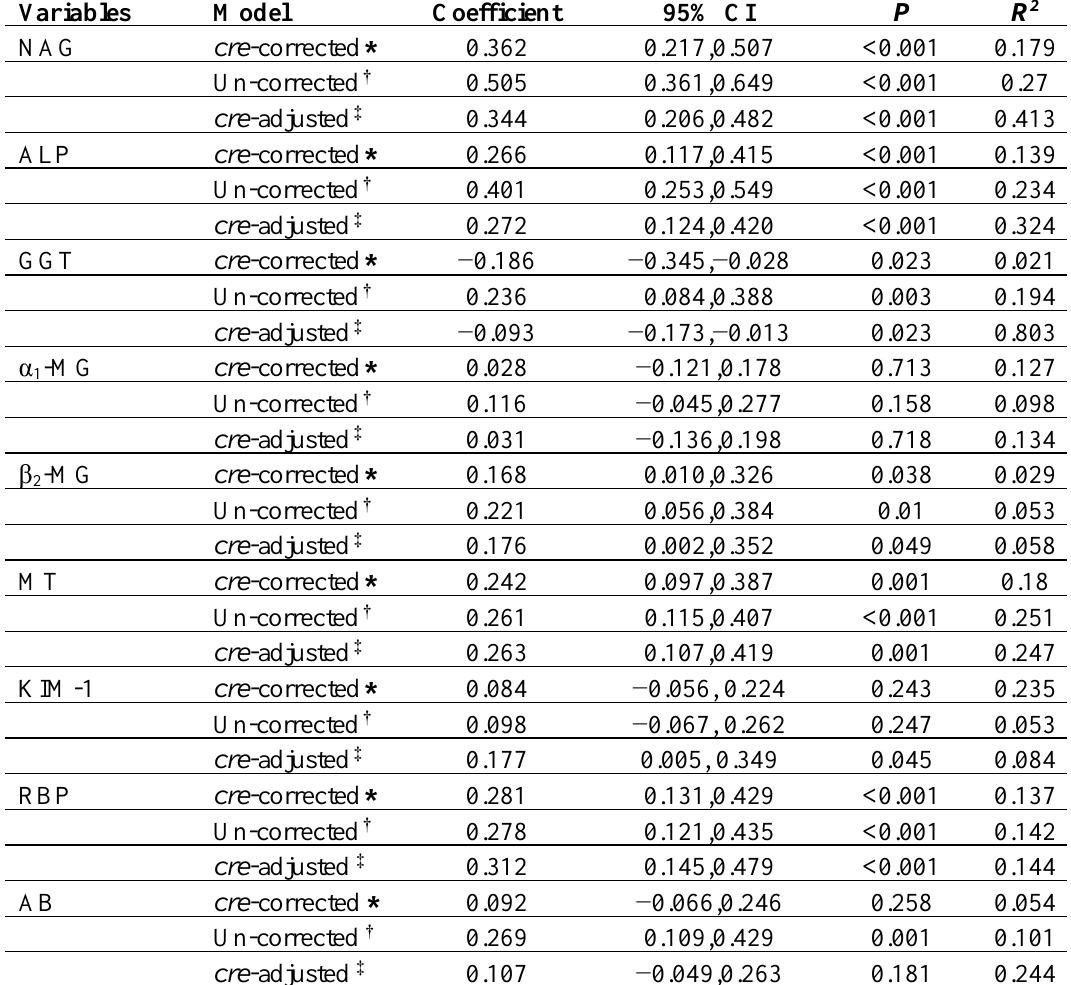
Table 4. Multiple linear regression analysis with nine renal markers as dependent variables based on three